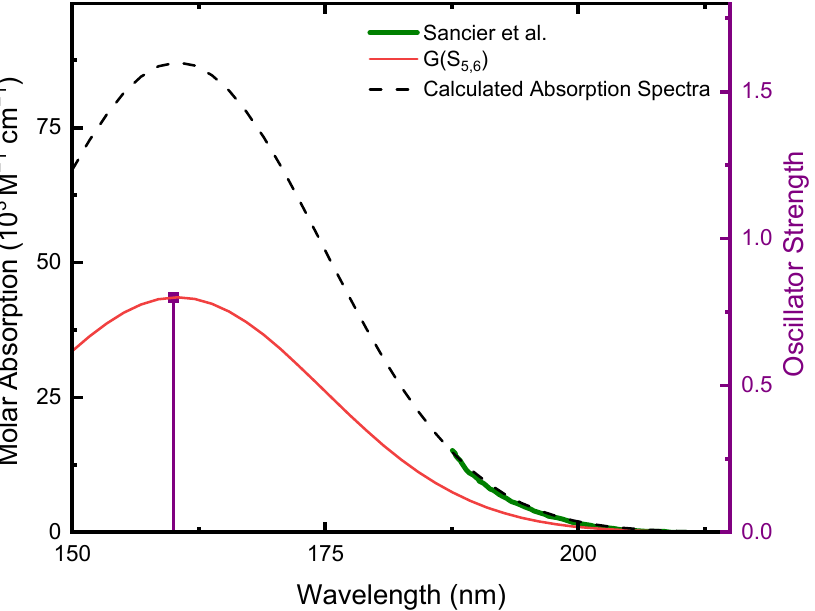
Figure 2. Calculated ground-state absorption spectrum of microsolvated CA at the TD-CAM- B3LYP/C-PCM/def2-TZVP//X3LYP/C-PCM/cc-pVDZ in water. The S 5 and S 6 oscillator strengths were convoluted with a Gaussian function (FWHM = 16 nm) centered at the vertical excitation energy of each state. The calculated absorption spectrum (dashed black line) is the result of the sum of the individual Gaussian functions of each state (red). Since both states have the same vertical energy and oscillator strength, the same result is obtained by multiplying the Gaussian function of one of the states by two. Shown in green is the absorption tail of CA at pH 4.4 (Adapted with permission from ref. [19]. Copyright 1964 Elsevier).